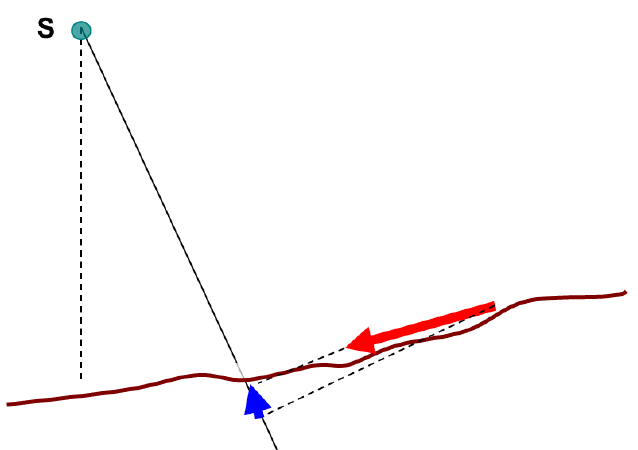
Figure 2: Scheme to illustrate the LOS geometry. The slope displacement (red arrow) is seen in the LOS direction as a displacement towards the satellite (blue